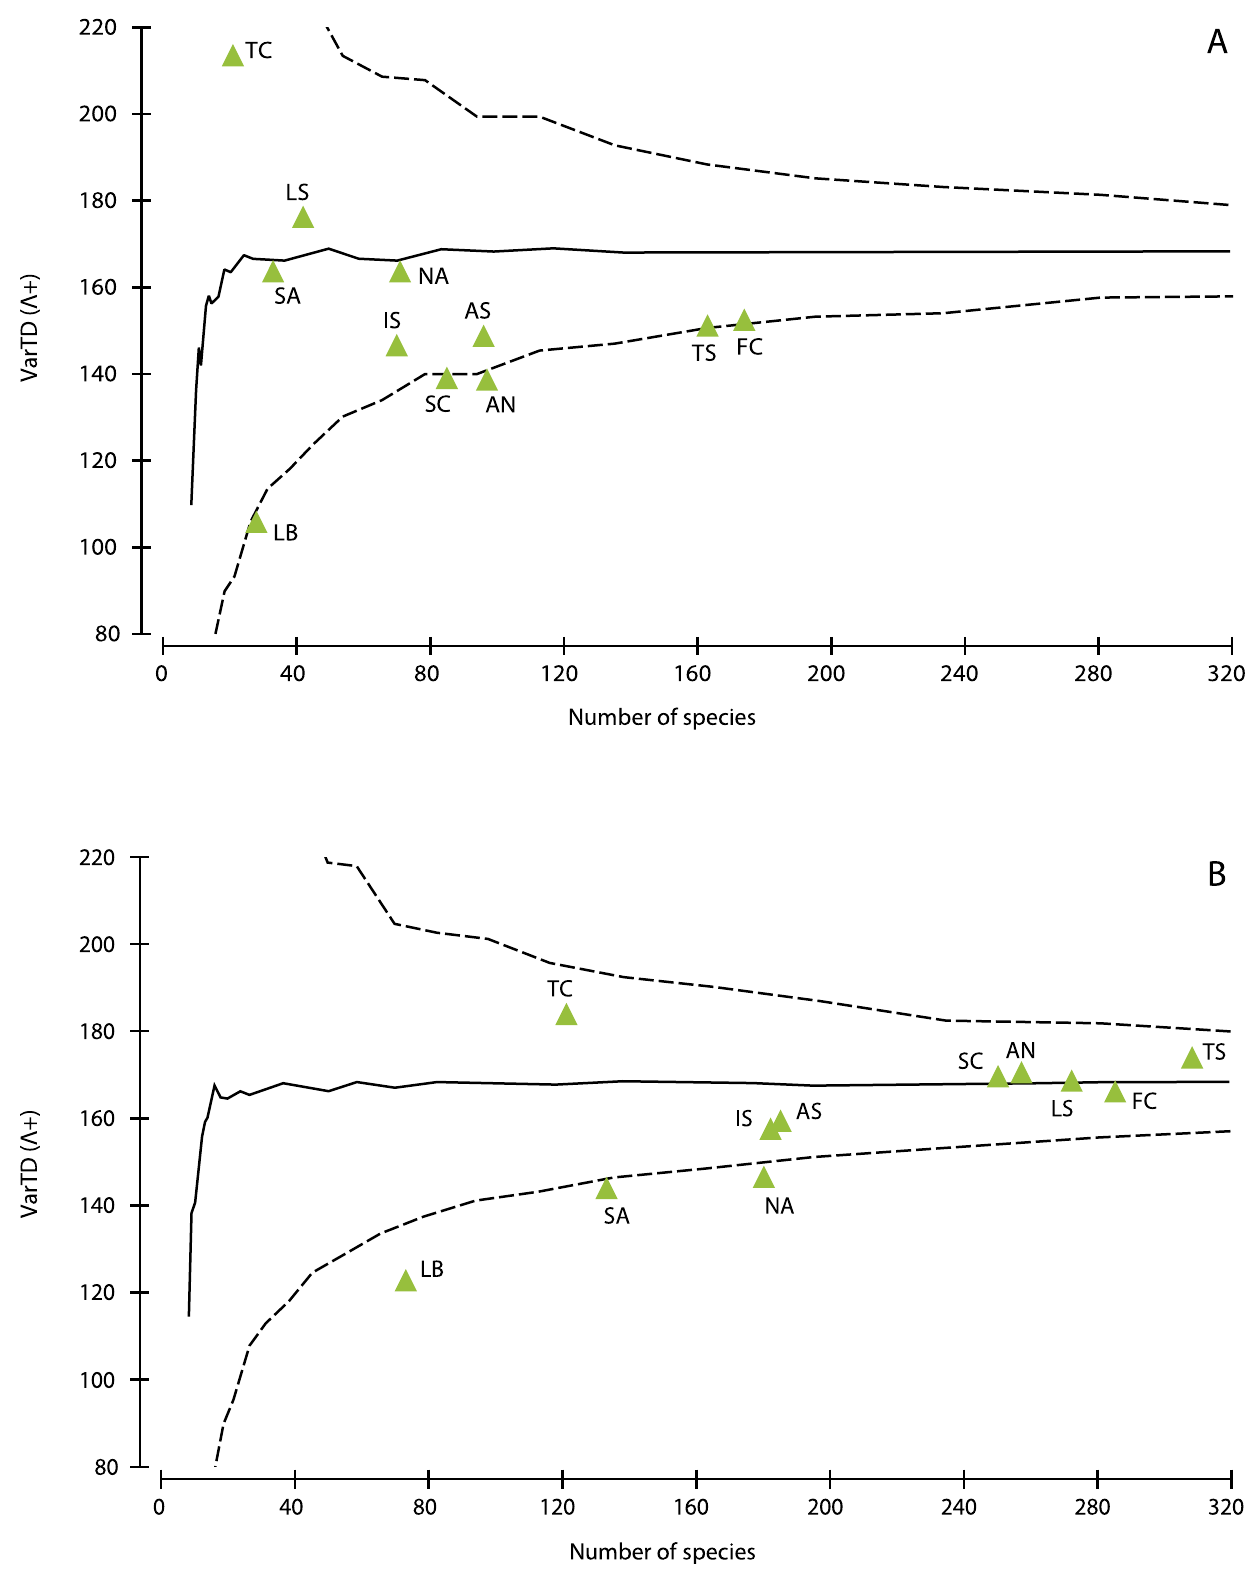
Figure 6. Variation in taxonomic distinctness (VarTD) for the Mediterranean subareas. (A) cave sponge fauna, (B) overall Mediterranean sponge fauna. The central line represents the mean value and the funnel curve shows the limits for its expected values. For abbreviations of Mediterranean areas see Methods.